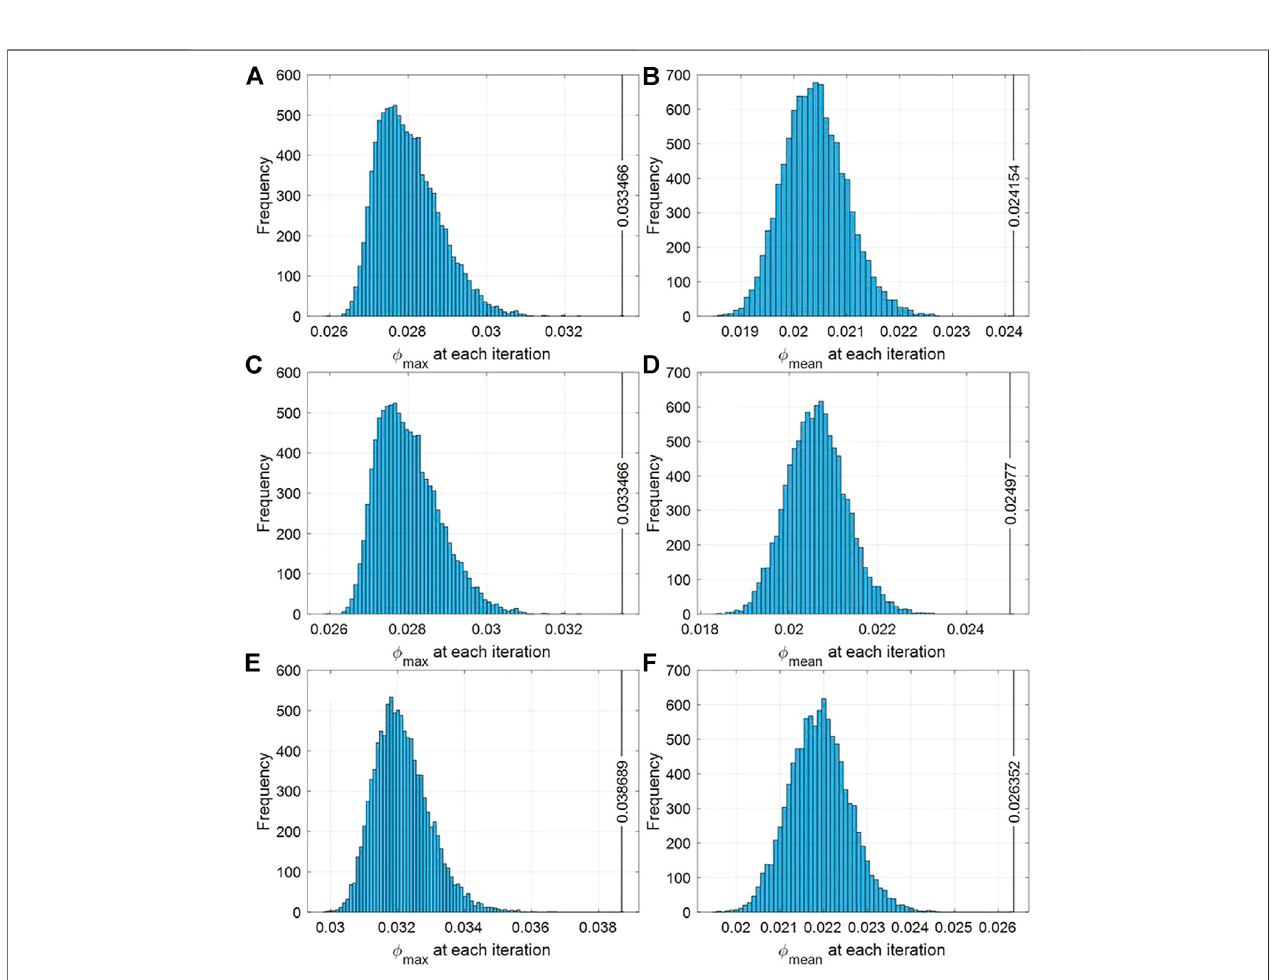
FIGURE8| Histogramofprobabilisticclusteringevaluationindicesforeachclusterata20%penetrationlevel. (A – C) ρ max ofClusters1,2,and3,respectively (D – F) ρ mean of Clusters 1, 2, and 3,